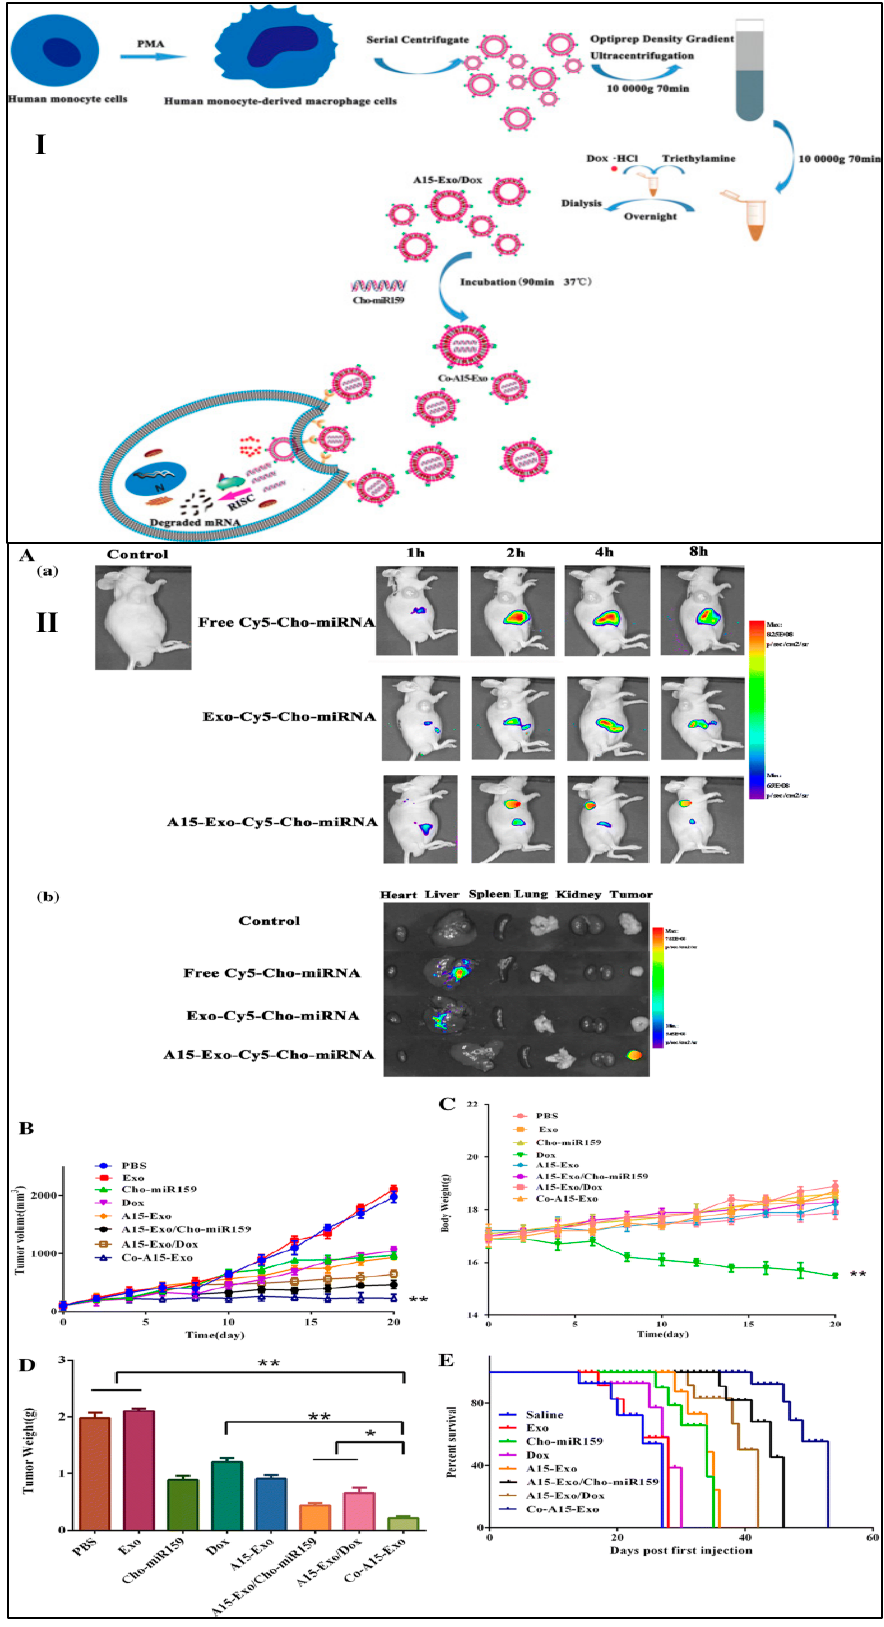
Figure 7. ( I ) Schematic diagram of isolation of exosomes, loading of Dox.Hcl and Cho-miR159 within the exosomes and release of Dox and Cho-miR159-loaded A15-Exo (Co-A15-Exo). ( II )